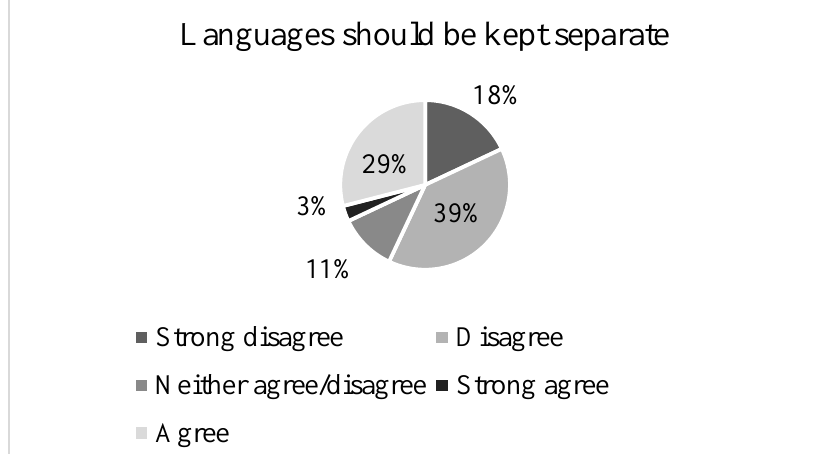
Figure 6. Participants’ attitudes toward mixing languages (Should be kept